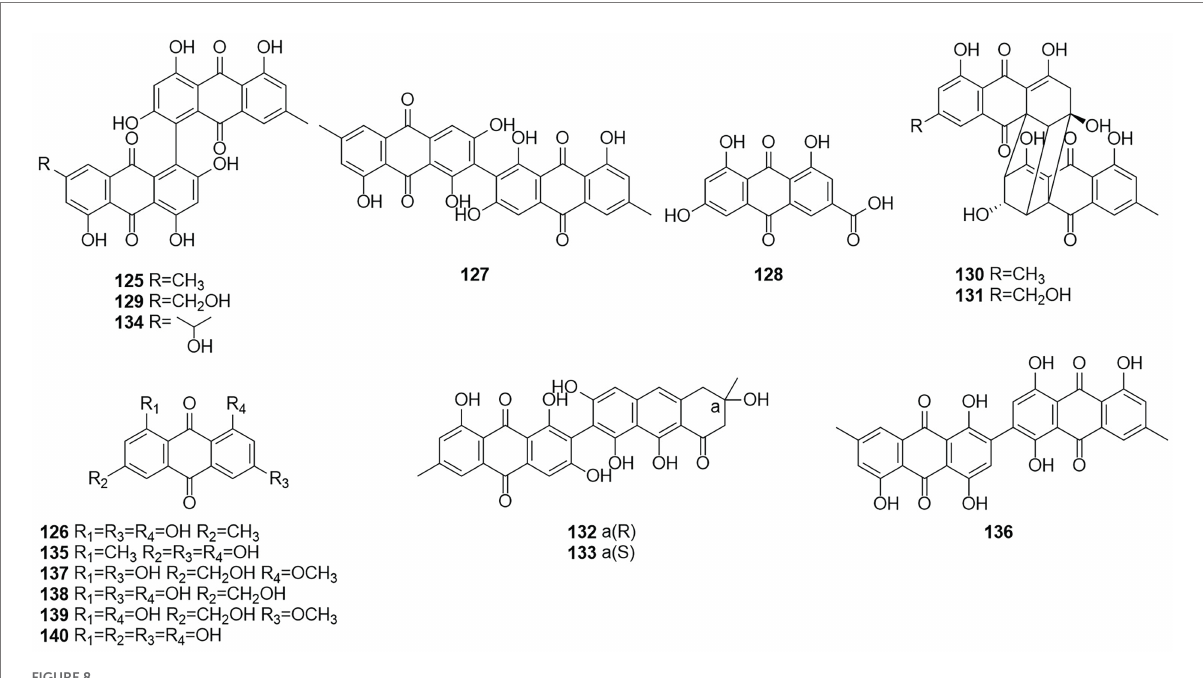
FIGURE 8 Chemical structures of compounds 125–140